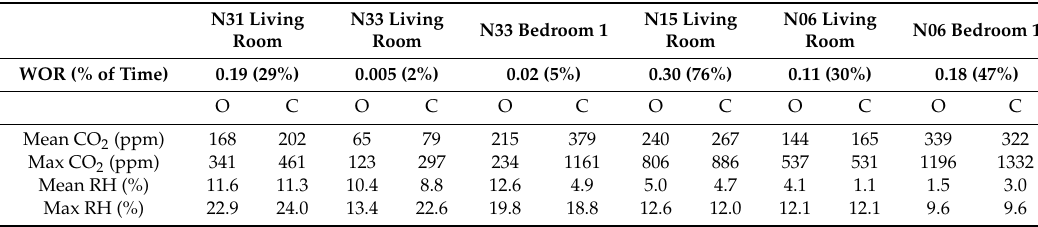
Figure 15. RH and window opening in the living rooms: ( a ) Flat N31; ( b ) Flat N06. Table 10. Di ff erence in interior and exterior CO 2 concentration and RH data from window opening (O = open, C = closed). Note: For most of the time the indoor RH was lower than outdoor; the mean and maximum figures are